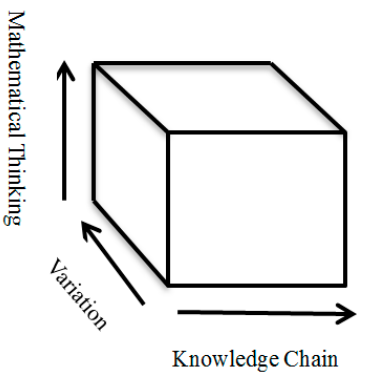
Figure 3. Model of teaching mathematical thinking.